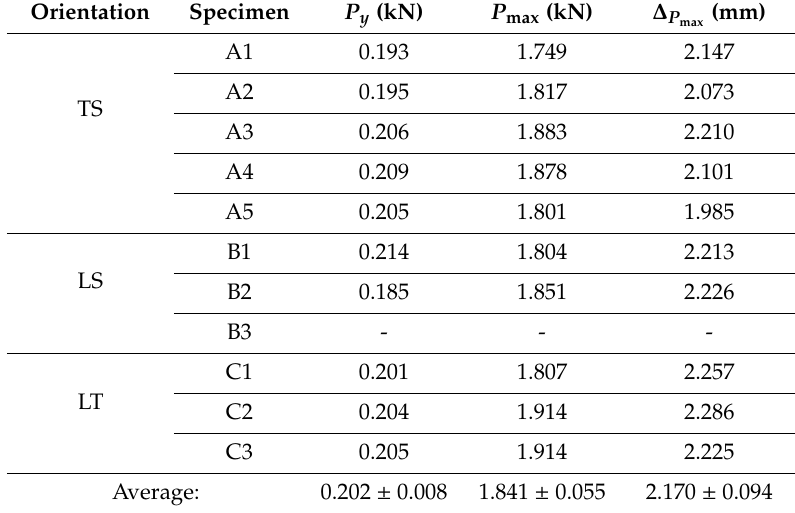
Table 3. Characteristic SPT parameters P y , P max and ∆ P pressing (CIP).